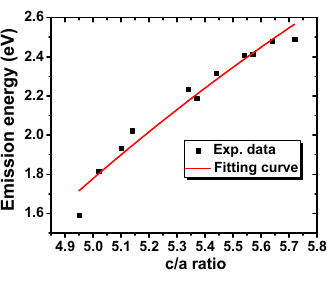
Figure 4. Emission maxima as a function of hexagonality ( c / a ) for the ALnS 2 :Eu.